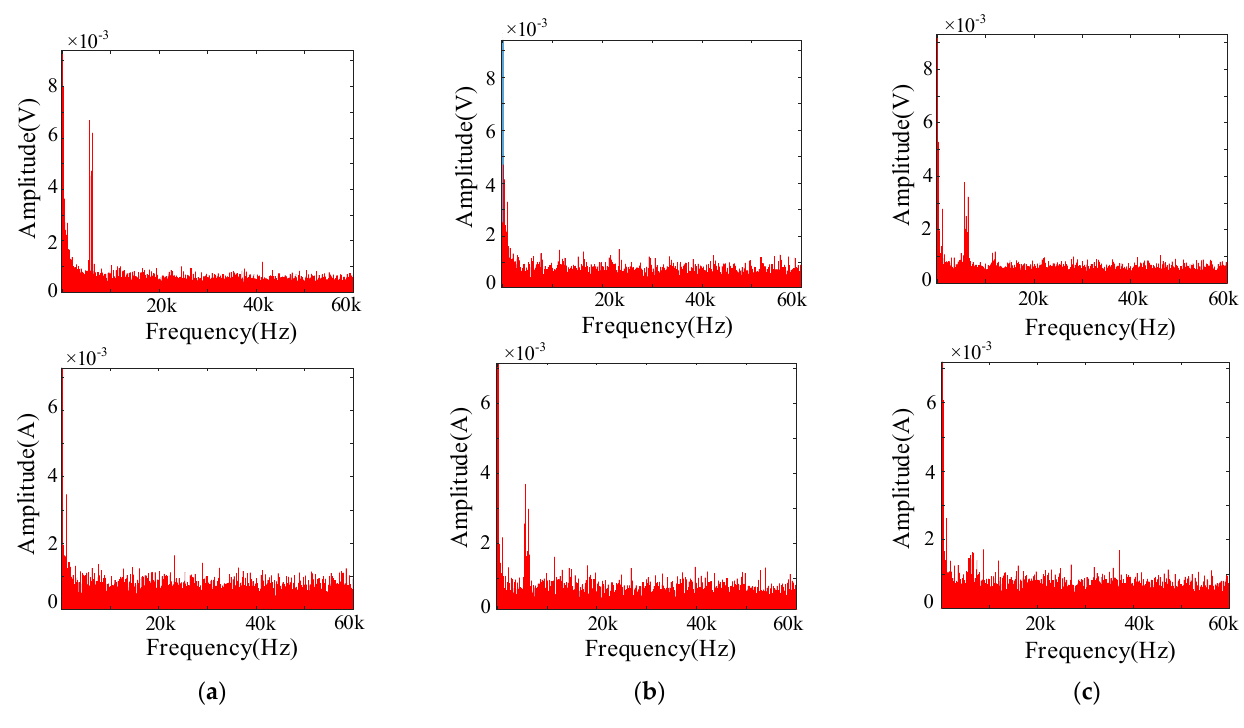
Figure 13. Experimental frequency spectrum of the output voltage and the circulating current when ( a ) θ = 0, ( b ) θ = π / N or ( c ) SDA-based CPS modulation is adopted.